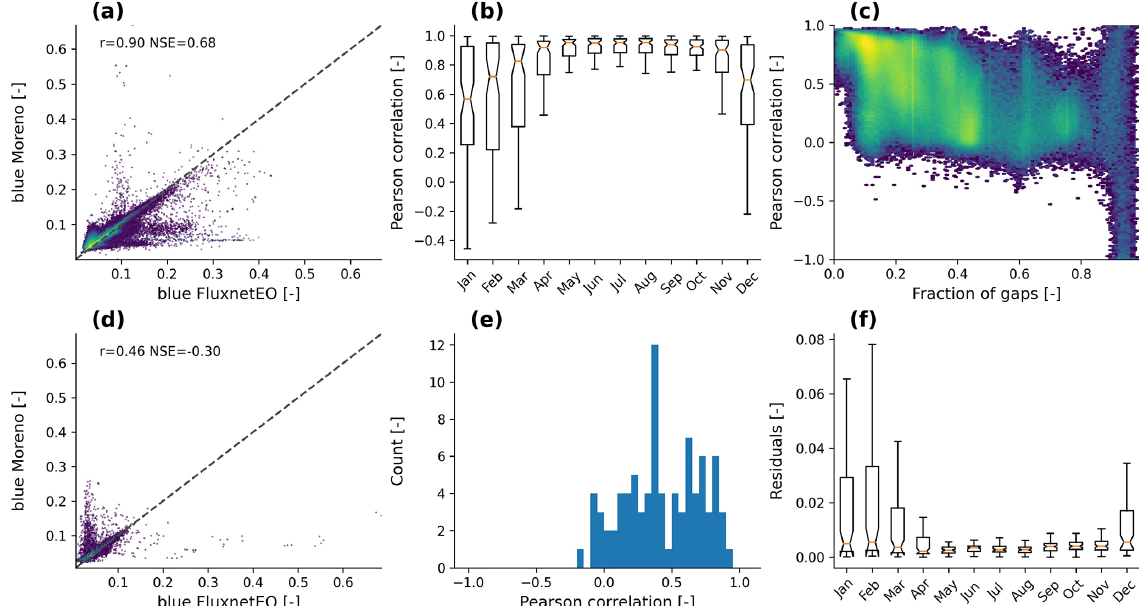
Figure C3. Benchmarking Landsat reflectance in the blue spectral band from FluxnetEO against the product produced by Moreno-Martínez et al. (2020) at EC sites in the CONUS. Each sample reflectance_s,t,p refers to one site ( s ), time step ( t ), and subpixel ( p ). Comparing spatial patterns: (a) scatterplot of the temporally averaged reflectance (mean(reflectance_s,p)_t); each dot reflects one subpixel and site. (b) Spatial Pearson correlation across all subpixels in a cutout per site of the average grouped by month. (c) Temporal correlation as a function of the number of missing values in each subpixel and site. (d–f) Compute a spatial average across all subpixels in a cutout per time step. (d) Temporal Pearson correlation of the spatial average. (e) Pearson correlation of the deviations from the mean seasonal cycle of the spatially averaged time series. (f) Difference between FluxnetEO and Moreno reflectance and their average per month of the year. r refers to the Pearson correlation coefficient and mef to the Nash–Sutcliffe efficiency (Nash and Sutcliffe,